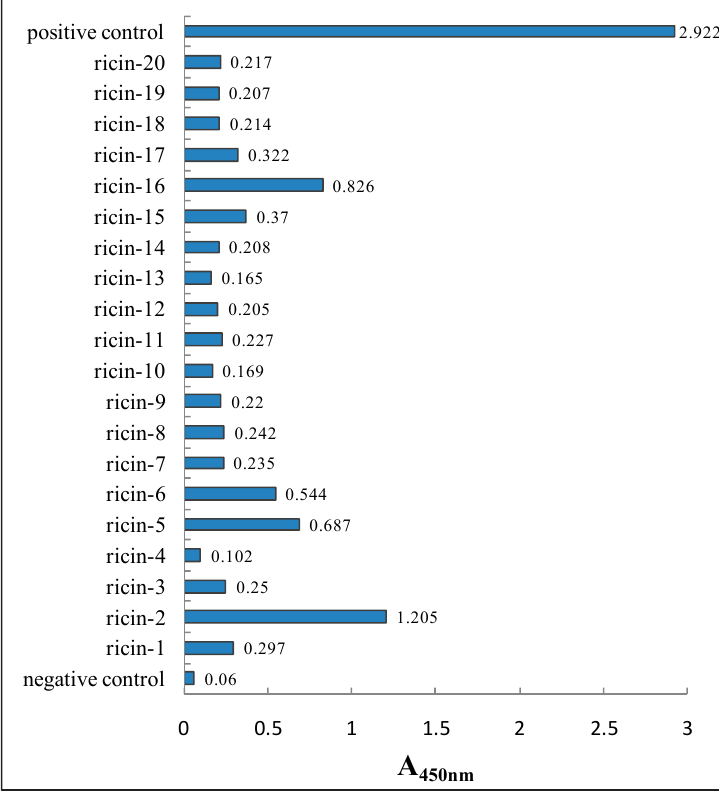
Figure 9. Determination of absorbance values of the 20 anti-ricin phage displayed antibody clones by ELISA.